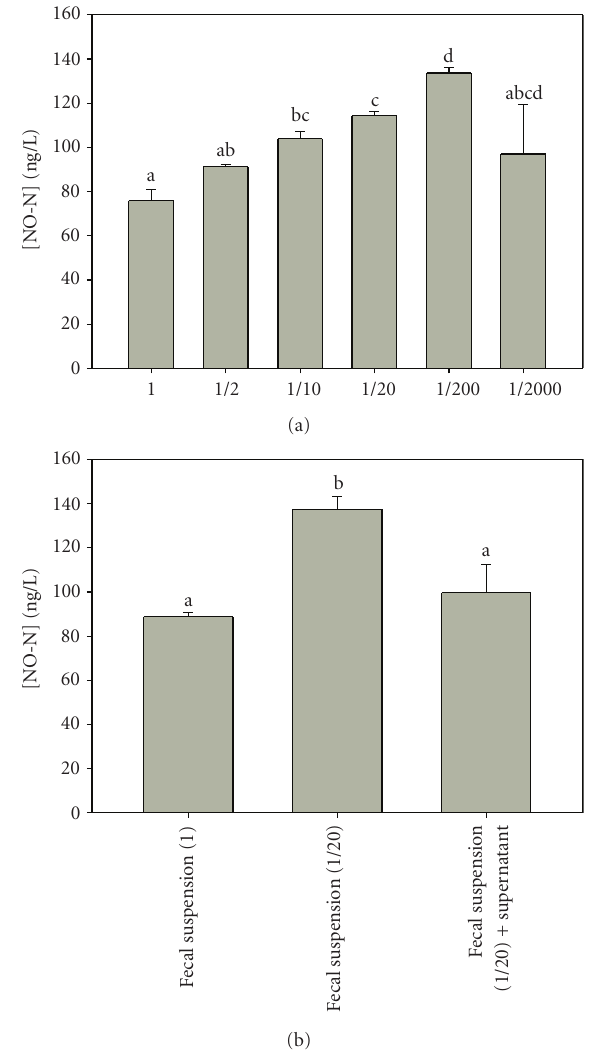
Figure 3: NO-N concentrations in function of the di ff erent dilutions of fecal suspension (a) and the inhibitory e ff ect of the supernatant of the fecal slurry (b). The inoculated medium was incubated anaerobically for 24 hours and the NO-N concentration measured in the headspace ( n = 3). Significant di ff erences are indicated with a, b, or c ( P < . 05). Results are means ± standard deviation of 3 incubations of fecal suspension from 1 representative person.